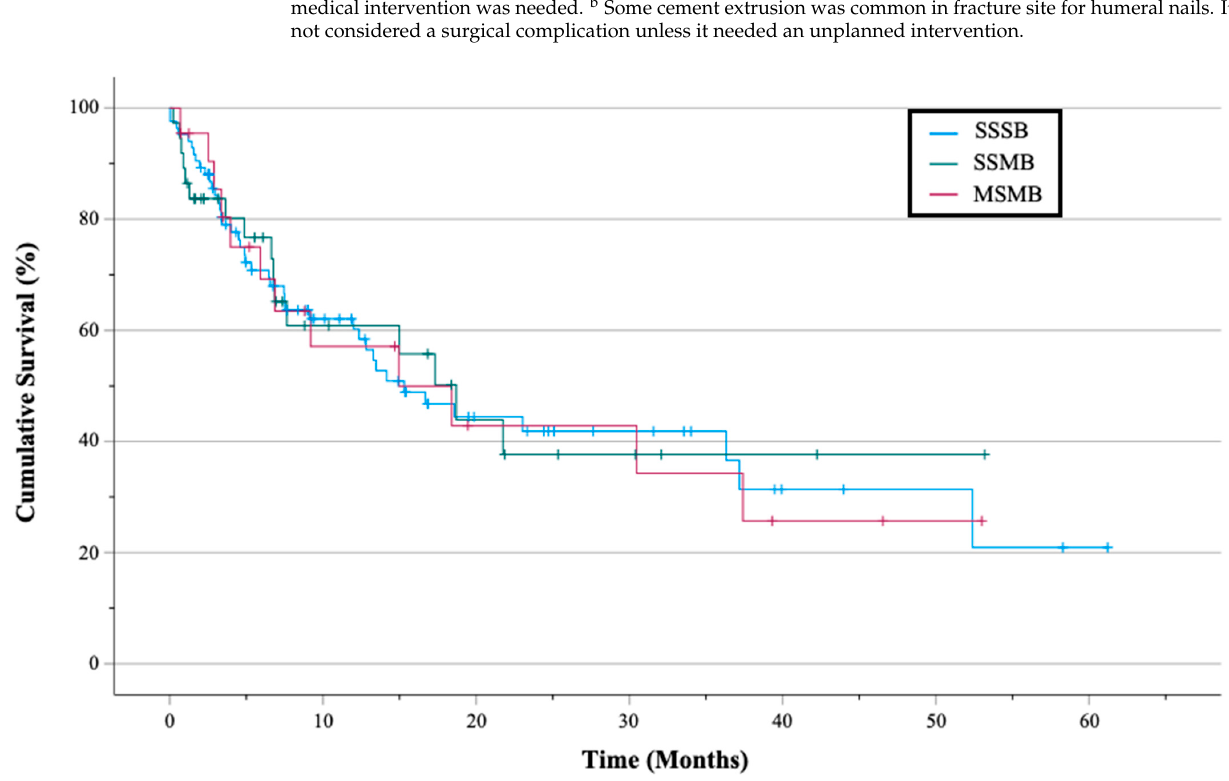
Figure 2. Kaplan–Meier survival curve comparing postoperative survival days of SSSB, SSMB, and MSMB groups ( p =